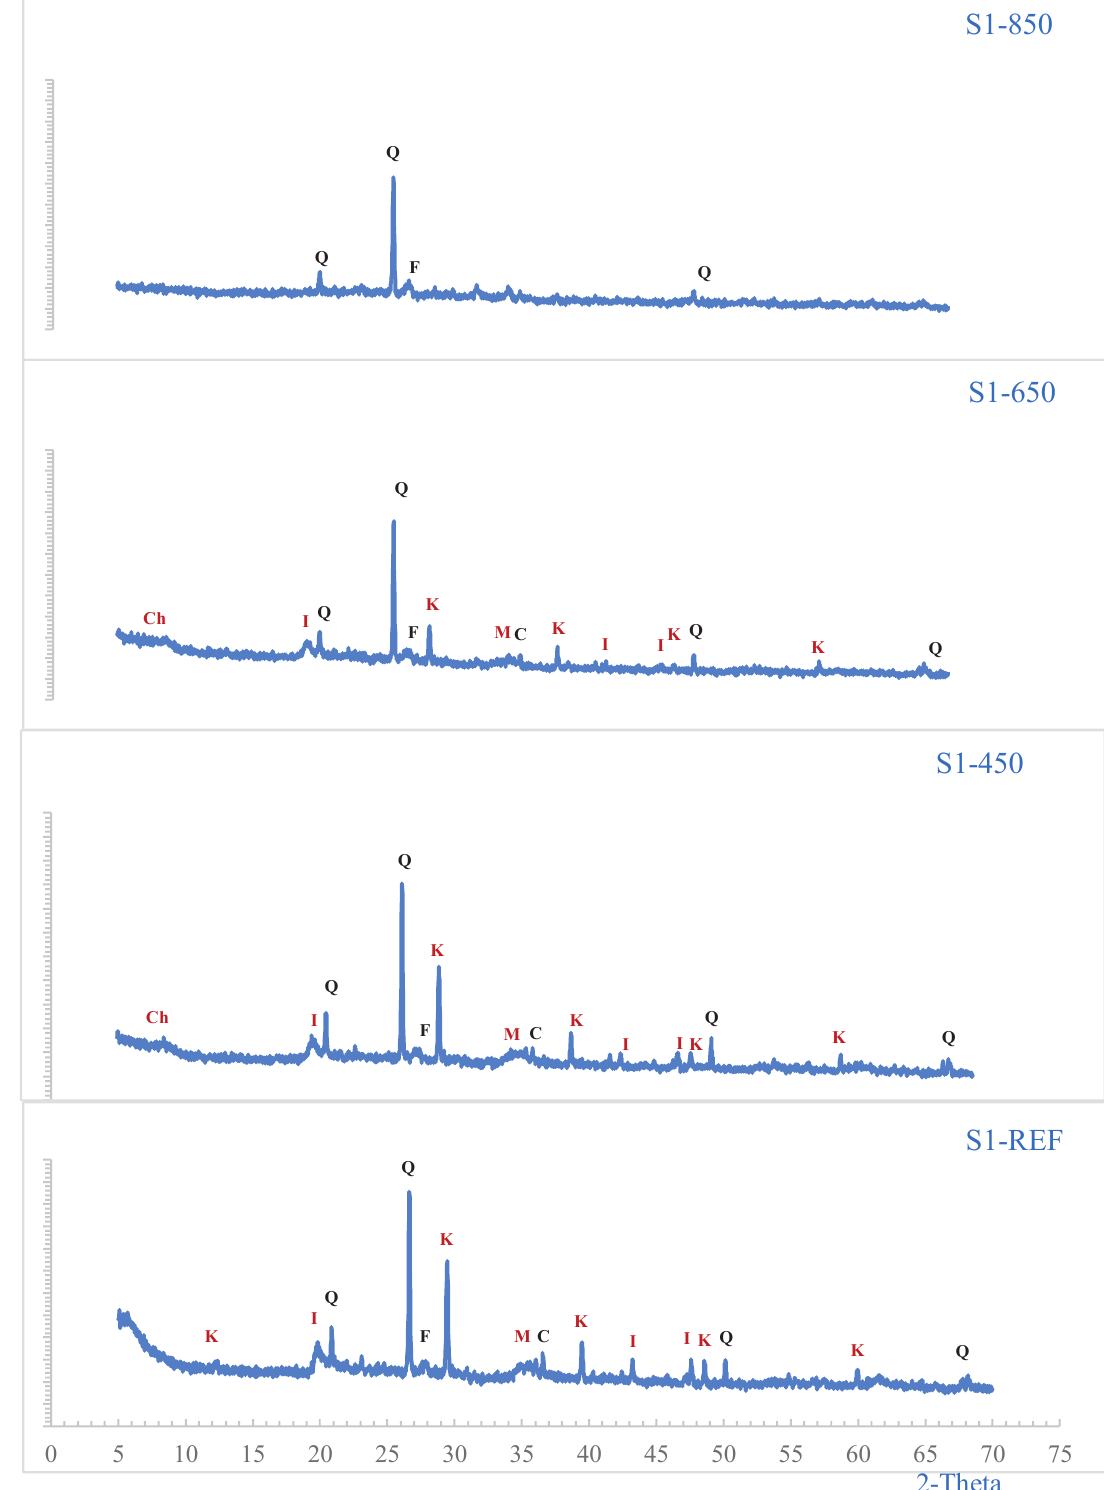
Figure 3. XRD analysis of the soil S1 before and after the thermal treatment (I: illite; Q: quartz; M: montmorillonite; K: kaolin; F: feldspar; C: calcite; Ch: chlorite).